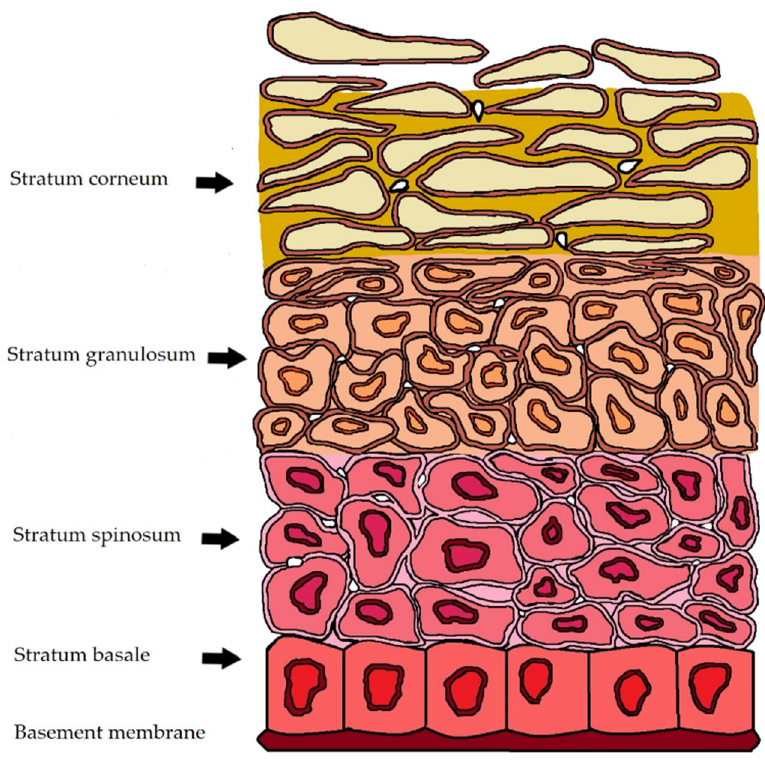
Figure 1. Schematic representation of the epidermis. Epidermis has a thickness of 0.1–0.2 mm. Stratum corneum (10–20 µ m) and the viable epidermis (50–150 µ m).